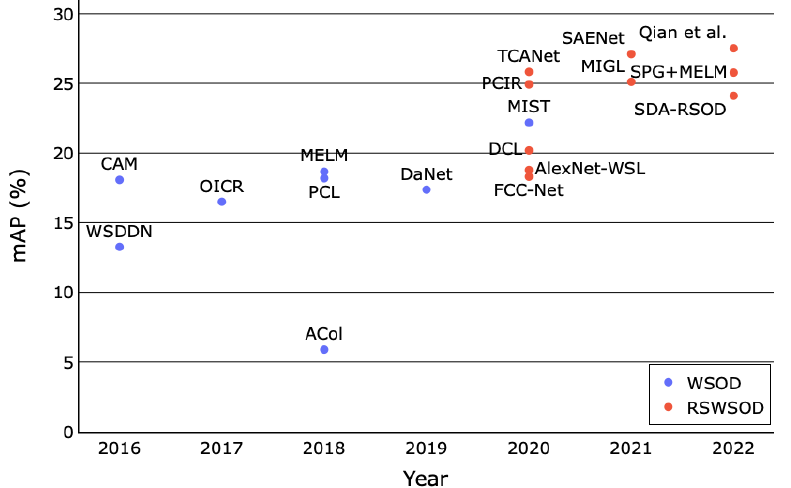
Figure 9. Mean Average Precision (mAP) trend of WSOD and RSWSOD methods on the DIOR dataset over the years. It is possible to notice that most RSWSOD methods are presented after 2020, and their performances are ≈ 5–10% better than the WSOD baselines